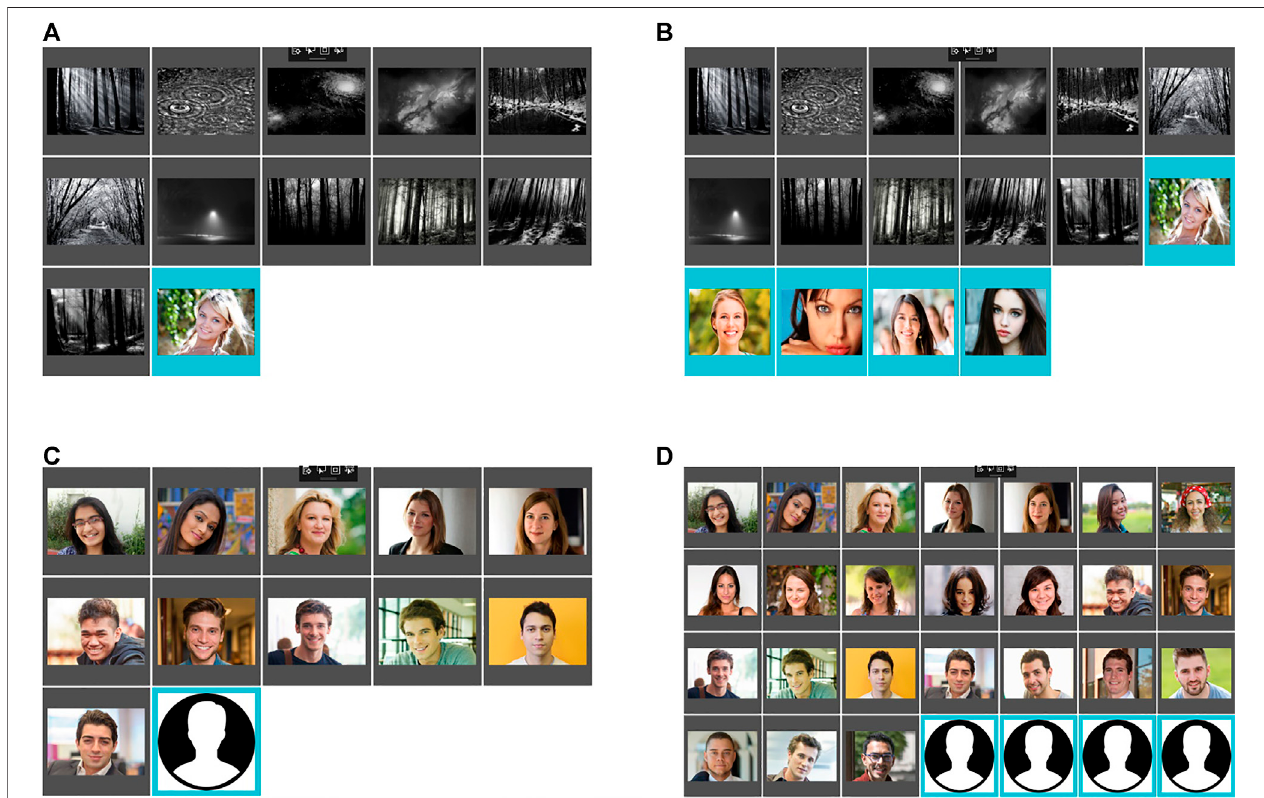
FIGURE2| Imagesetsusedfortheoddballparadigms: (A) Paradigm1 “ P1 ″ containingonefemaleface(targetclass)and11gray-scaleimages(non-targetclass), (B) Paradigm 2 “ P2 ″ containing fi ve female faces (target class) and 11 gray-scale images (non-target class), (C) Paradigm 4 “ P4 ″ containing one familiar face (target class) and 11 unfamiliar faces (non-target class), (D) Paradigm 3 “ P3 ″ containing four familiar faces (target class) and 24 unfamiliar faces (non-target class). The pictures of the familiar faces are different for each subject. Thus they are replaced by placeholders-icons in (C) and (D) .